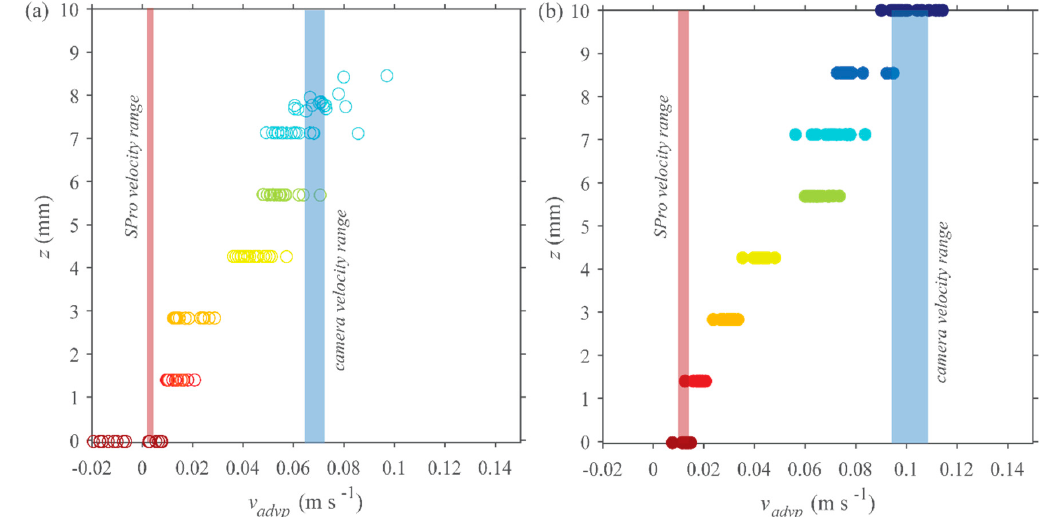
Figure 5. UniBo bedload velocity profiles measured at both position and the range of ADCP SPro and camera velocities ( a ) EXP1, weaker transport conditions, U = 0.42 m s − 1 ; ( b ) EXP2 intensive transport conditions, U = 0.58 m s − 1 .